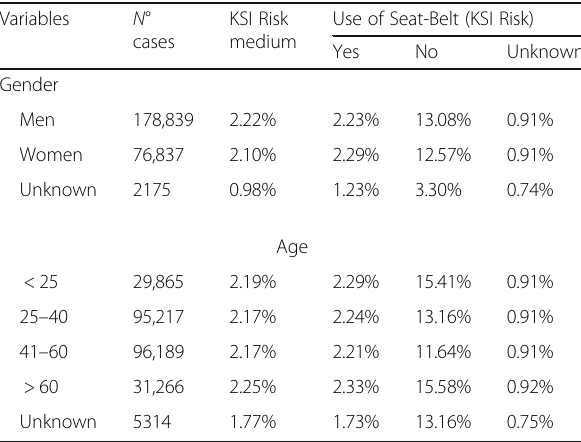
Table 4 Probabilities of suffering a serious injury, depending on the use of seat belt and the different variables of the demographic factor. Processed by the